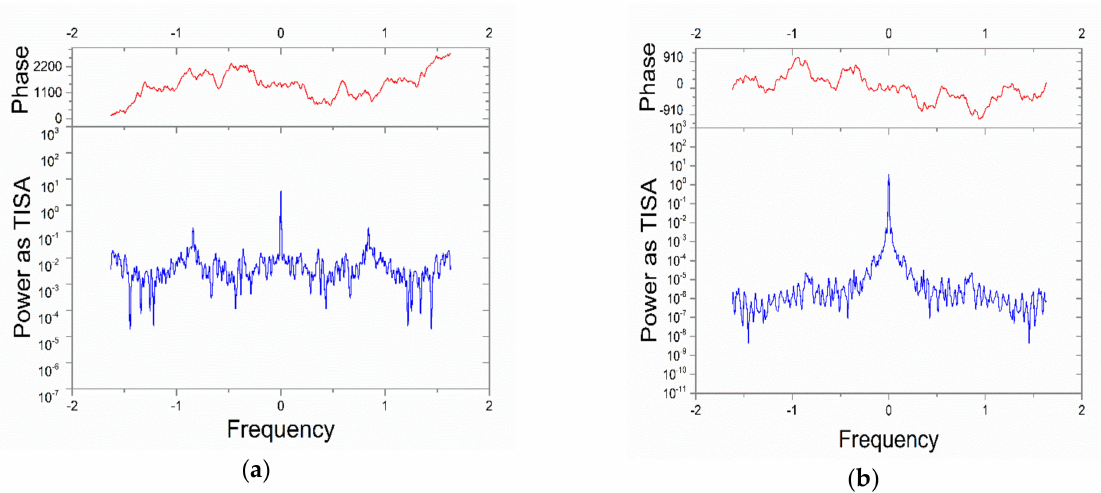
Figure 5. Frequency analysis on the current measurements before ( a ) and after filtering ( b ) associated to the current response of DIW at v = 2.6 cm /